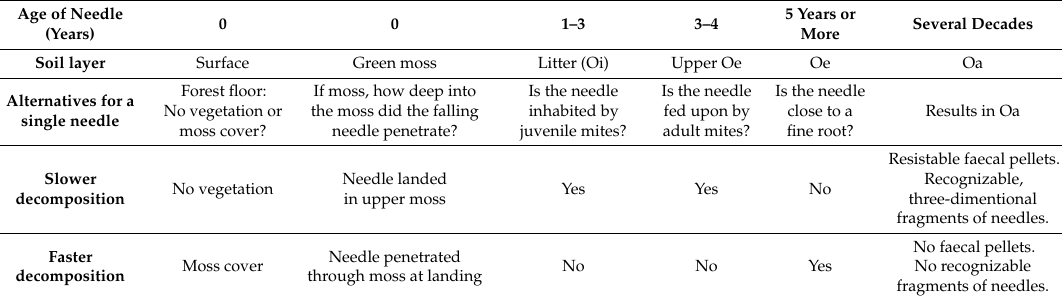
Table 4. Alternative decomposition pathways for individual spruce needles. Options are many, since each alternative may have two new alternatives in the following